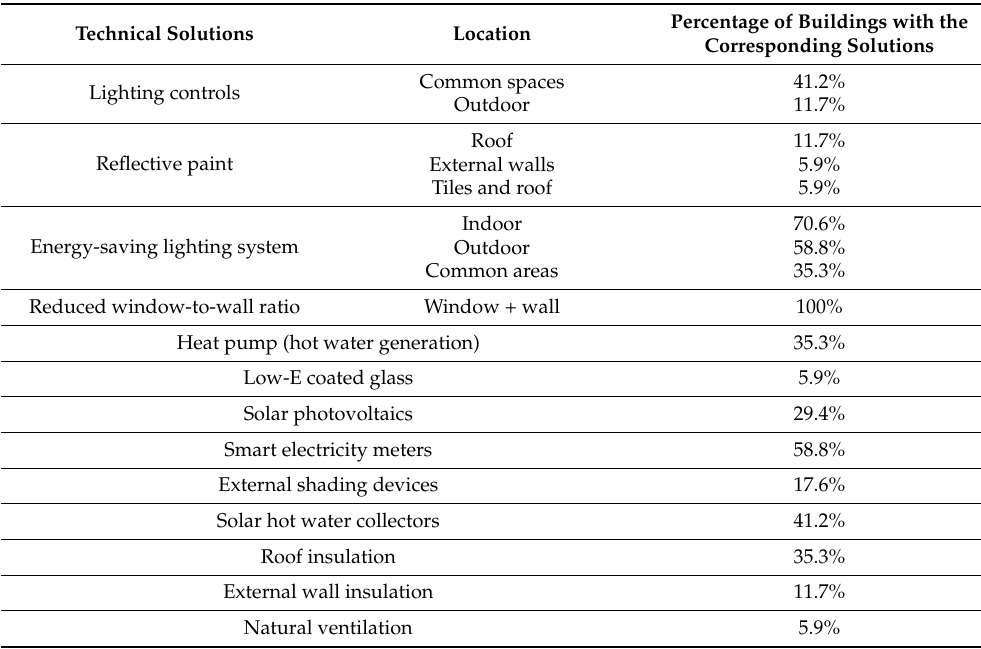
Table 5. Summarized energy-related technical solutions of the 17 residential complexes in South Africa with EDGE certification [40].